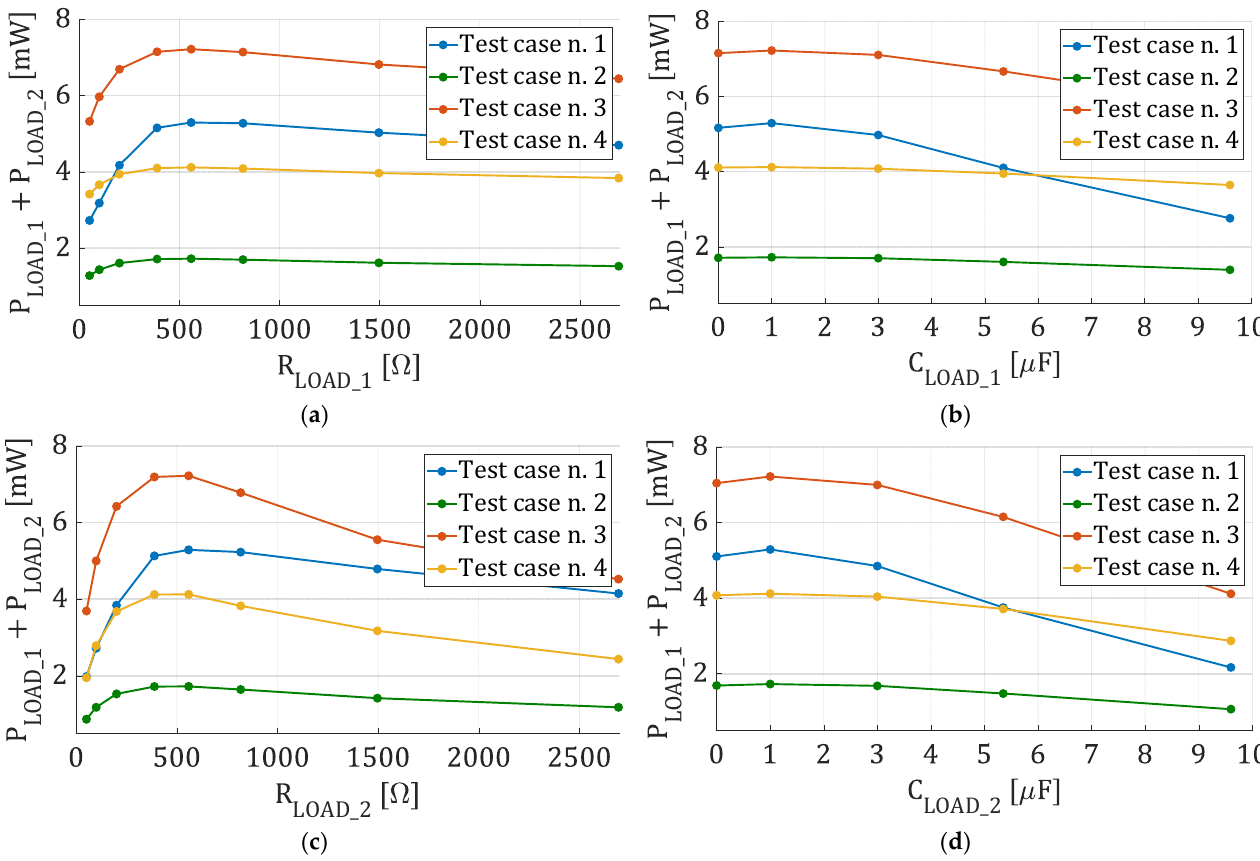
Figure 14. Measured load average power for the double coil circuit in Figure 11a, in the four test cases. ( a ) Power as a function of R LOAD_1 for the optimal values of C LOAD_1 , R LOAD_2 and C LOAD_2 . ( b ) Power as a function of C LOAD_1 for the optimal values of R LOAD_1 , R LOAD_2 and C LOAD_2 . ( c ) Power as a function of R LOAD_2 for the optimal values of C LOAD_2 , R LOAD_1 and C LOAD_1 . ( d ) Power as a function of C LOAD_2 for the optimal values of R LOAD_2 , R LOAD_1 and C LOAD_1 . Table 2. Experimental tests on the electrical circuits of single coil and double coil harvesters.